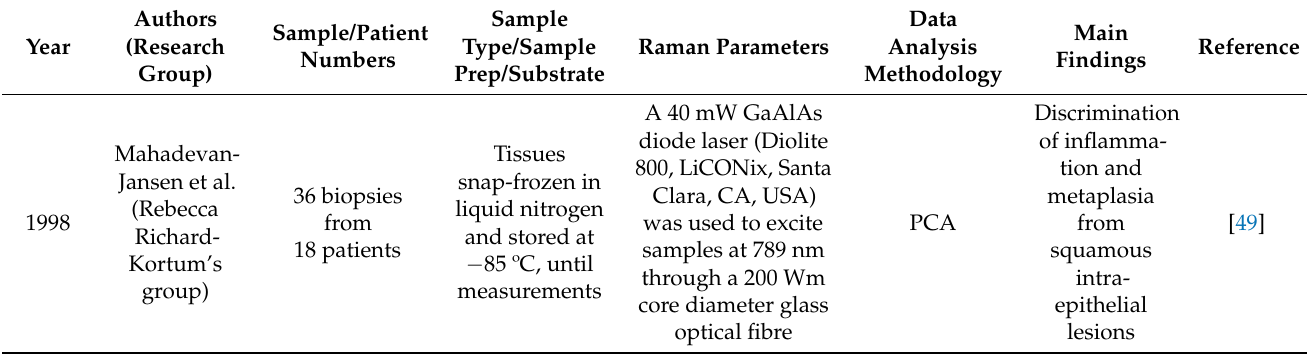
Table 2. Application of Raman spectroscopy in cervical tissues (ex